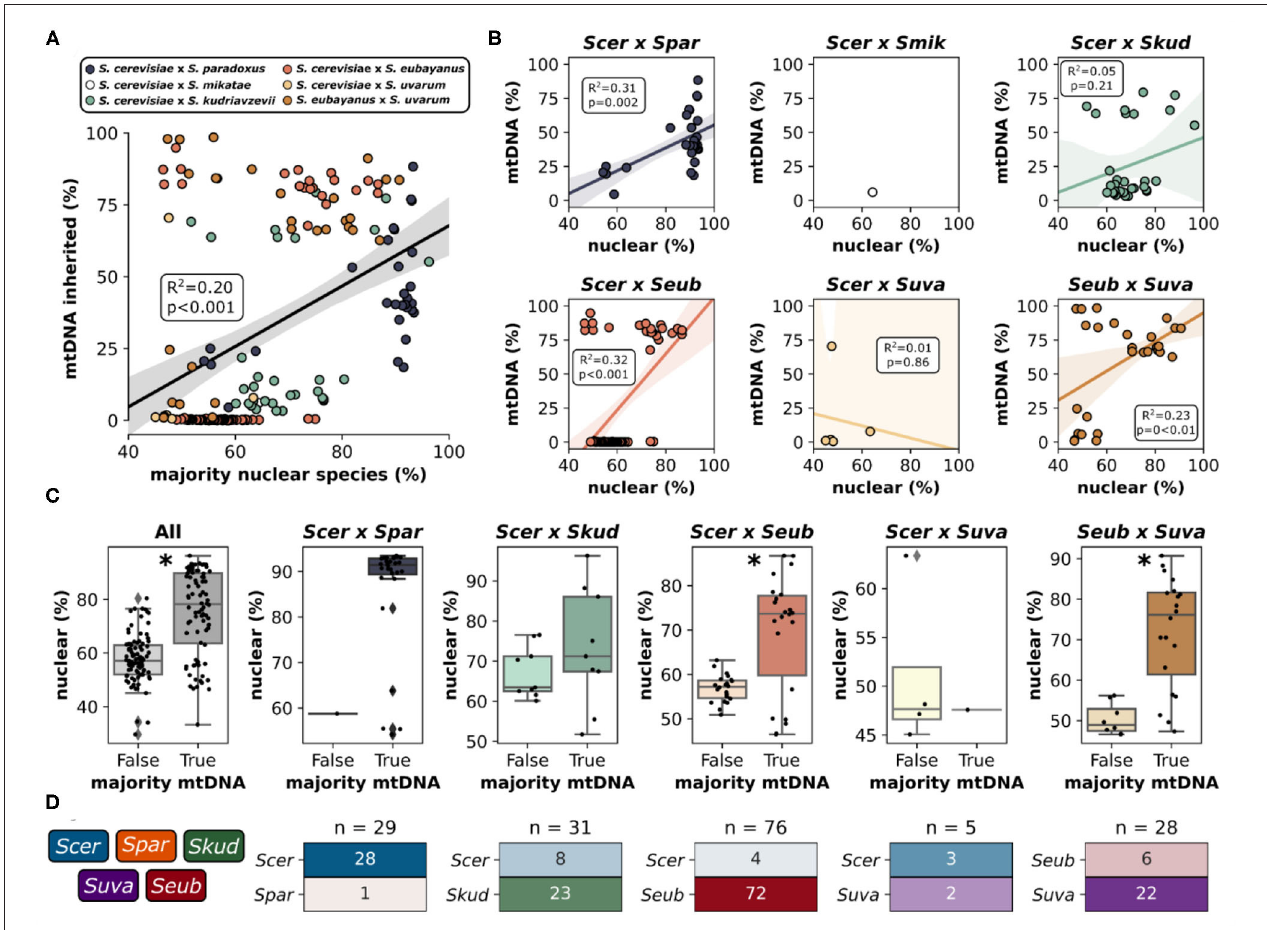
FIGURE 4 | Mitochondrial inheritance patterns in interspecific hybrids. (A) Relationship between the percentage (%) of reads mapping to the majority nuclear species and mtDNA inherited from the majority nuclear species for all hybrid crosses. Data points are colored according to the hybrid cross. Linear regression is shown as black line with 95% confidence interval. X-axis extends below 50% as some of the Scer × Seub hybrid genomes remained unmapped or mapped to a third parent species (B) Relationship between the majority nuclear species and mtDNA inheritance for each pairwise hybrid cross. (C) Mitochondrial inheritance as a function of nuclear species majority (% reads mapping to that species). False indicates that the most frequent mitochondrial genome is not from the majority nuclear genome. True indicates that the most frequent mitochondrial genome and the majority nuclear genome are from the same species. Asterisk indicates a significant difference ( p < 0.05) from Welch’s t -test. Scer × Spar and Scer × Suva could not be tested as one of the categories only had a single value. (D) Mitochondrial inheritance for each species within each hybrid cross. n indicates the number of hybrids within a particular hybrid cross. The heatmap is colored and labeled according to the percentage of each hybrid cross that dominantly inherited mitochondria from each species. Colors and color intensity match the color scheme in Figure 3 .